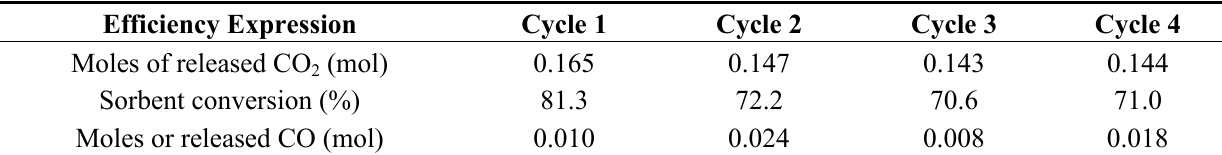
Table 7. Results of calcination phase for all the